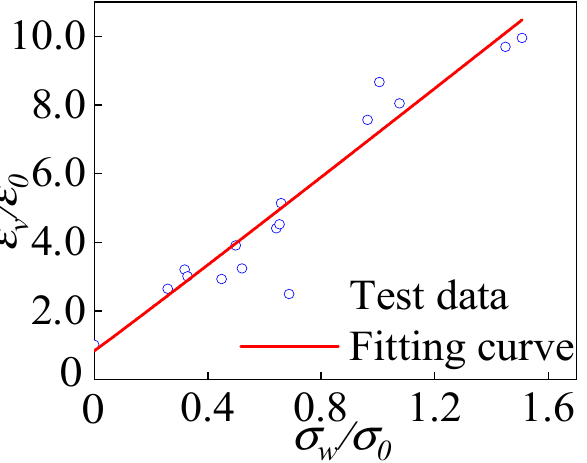
Figure 19. Relationship between peak strain and confining pressure value.